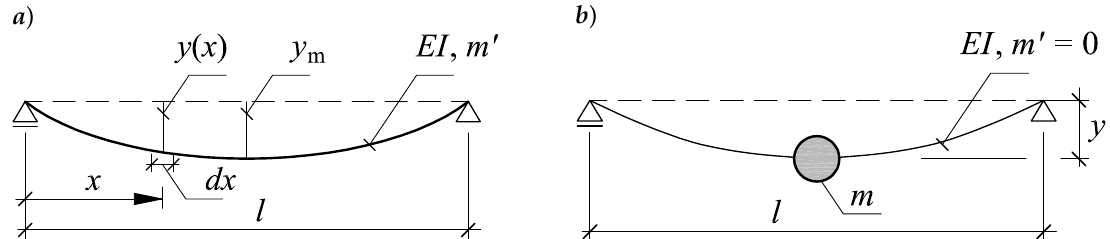
Figure 3. Reduction of the beam with continuous mass distribution to the system with one degree of freedom: ( a ) system with continuous mass distribution m (cid:48) and ( b ) substitute mass m concentrated in a point where the vibration arrow of the system with continuous mass distribution